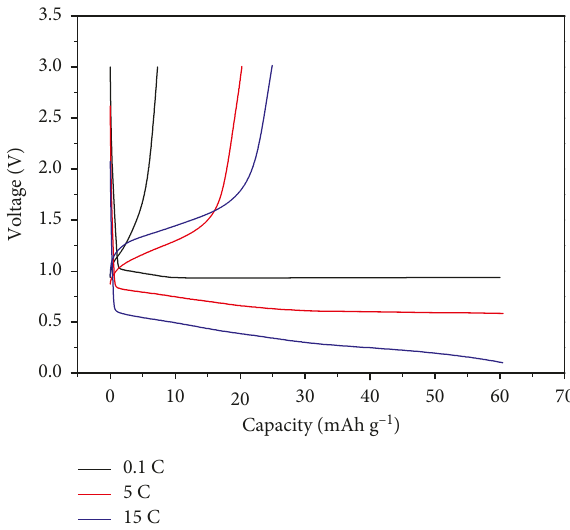
Figure 1: Voltage profiles of NG-7 at various C-rates in 1M LiClO 4 /PC, with the cell charged to 60mAh ·